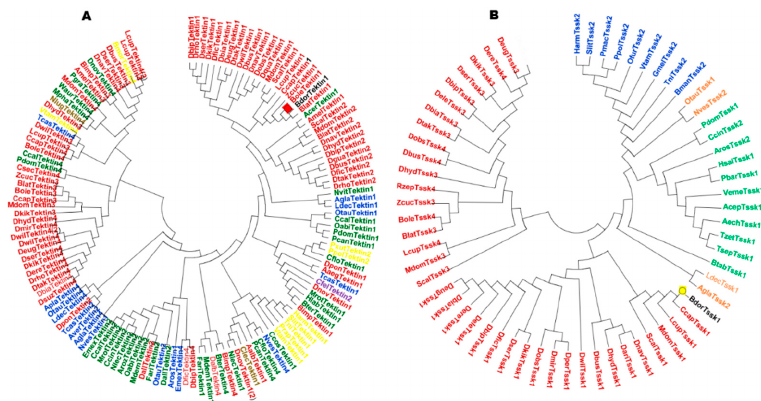
Figure 1. Phylogenetic analysis of Tektin, and Tssk gene family of B. dorsalis and different insect species. I41 proteins of Tssk and 63 proteins of Tektin family were analyzed. Different colors indicate different orders of insects. Black color indicates B. dorsalis ( A ) mehroon (Diptera), blue (Coloeopltera), yellow (Lepidoptera), green (Hymenoptera), purple (Siphonaptera), and red (Blattodae). ( B ) Mehroon (Diptera), green (Hymenoptera), blue (Lepidopters), and orange (Coleoptera). Names of different insects are Aaeg ( Aedes aegypti ), Acer ( Apis cerana ), Agla ( Anoplophora glabripennis ), Amel ( Apis mellifera ), Apla ( Agrilus planipennis ), Aroz ( Athalia rosae ), Aver ( Asbolus verrucosus ), Bdor ( Bactrocera dorsalis ), Bimp ( Bombus impatiens ), Blat ( Bactrocera latifrons ), Bole ( Bactrocera olea ), Bter ( Bombus terrestris ), Bmor ( Bombyx mori